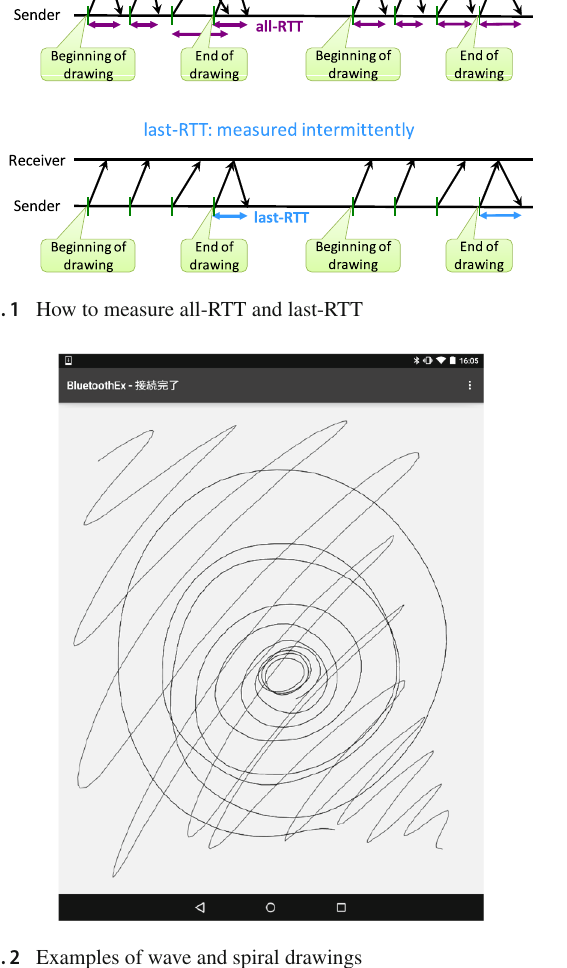
Fig. 2 Examples of wave and spiral drawings